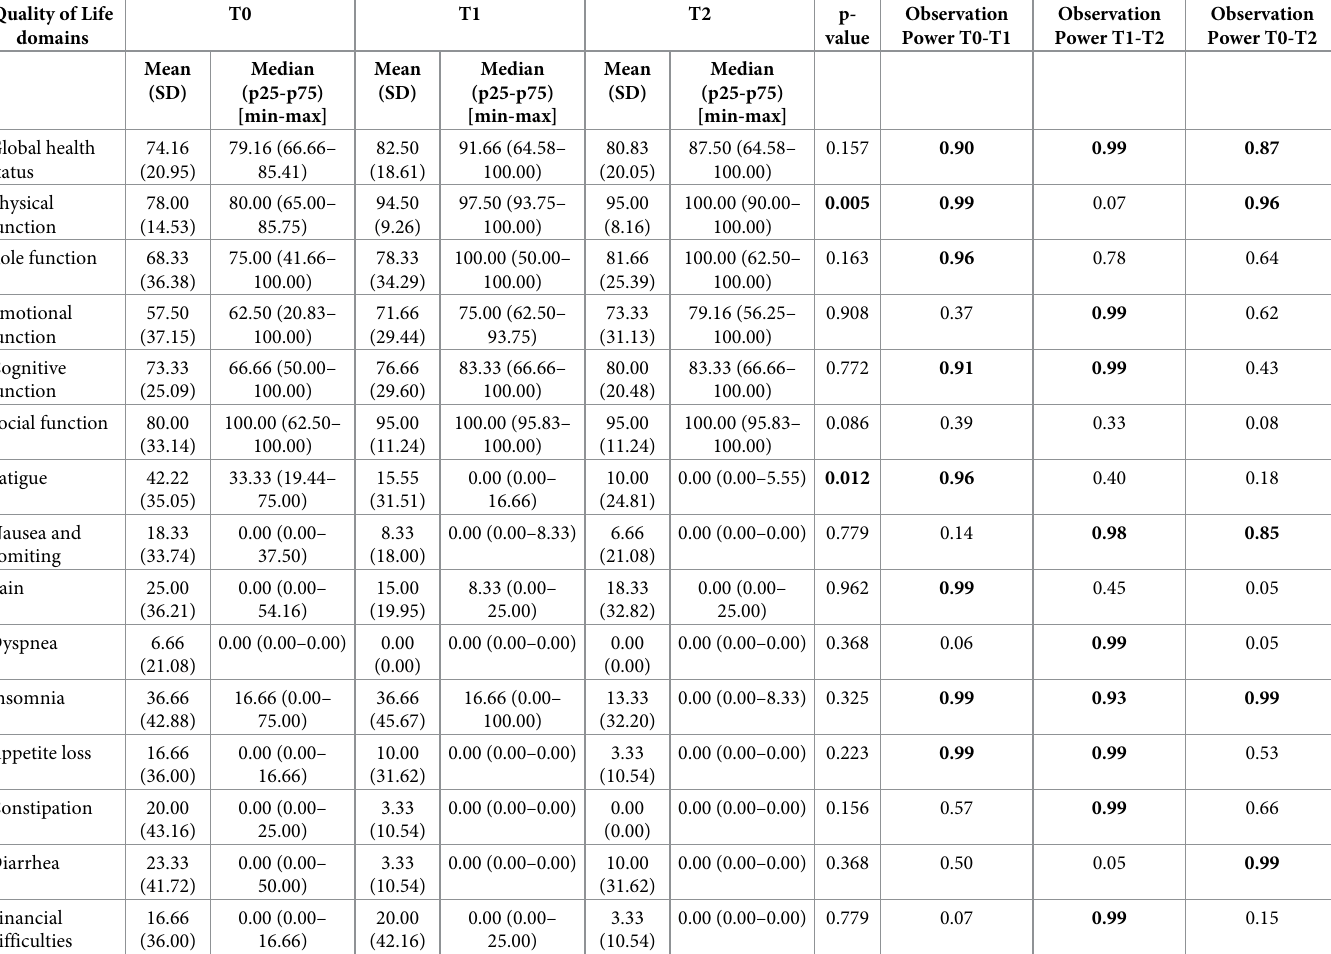
Table 2. Synopsis of EORTC QLQ-C30 longitudinal score differences and corresponding p-values according to quality of life scales for patients with colostomy due to colorectal